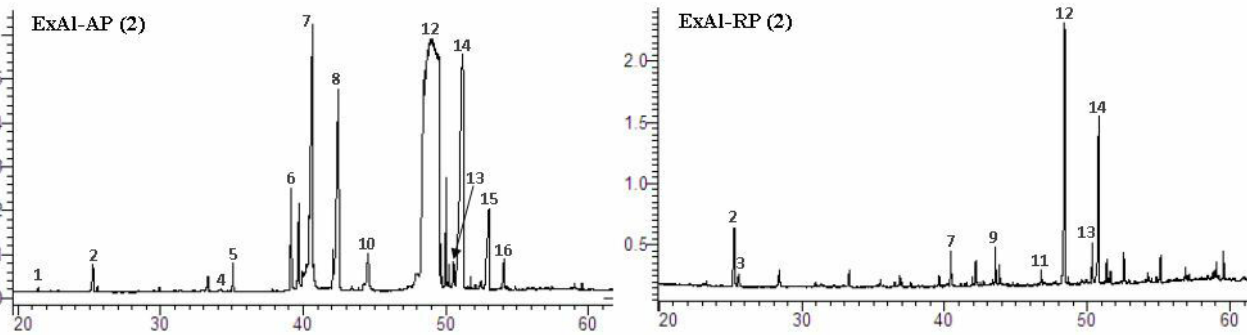
FIGURE 3 - Chromatograms of the acetylated alkaloids extracts, obtained by the second extraction protocol in the aerial and root parts of Haloxylon scoparium.